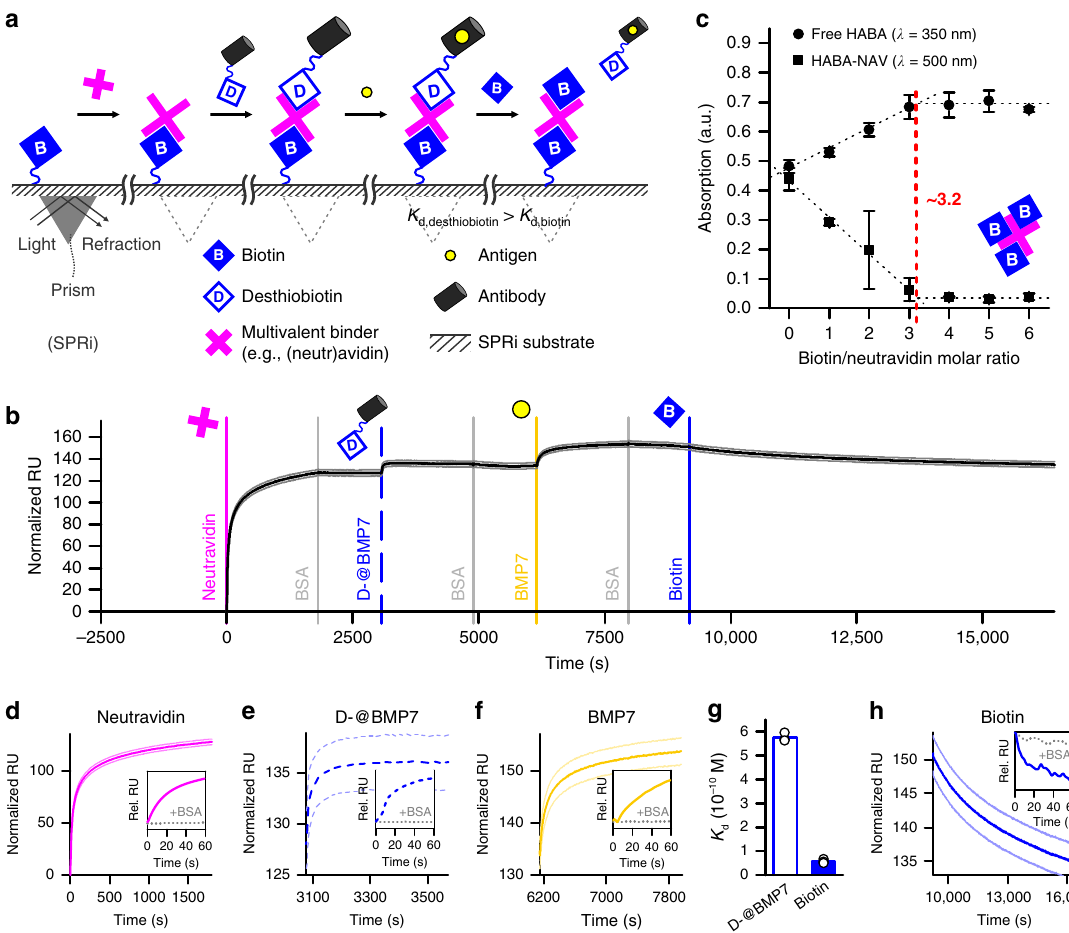
Fig. 1 Reversible functionalization via competitive supramolecular complexation. a , b Surface plasmon resonance imaging (SPRi) was used to monitor the (single) reversible functionalization of a biotinylated 2D substrate through supramolecular complexation of multivalent (i.e., with multiple binding pockets) (neutr)avidin and desthiobiotinylated antibody. c The multivalent nature of neutravidin was con fi rmed using spectrophotometric absorption analysis of 4 ′ -hydroxyazobenzene-2-carboxylic acid bound to neutravidin (HABA-NAV; λ = 500 nm), which was displaced by biotin resulting in unbound (i.e., free) HABA ( λ = 350 nm). b , d – f Following a cascade binding strategy, neutravidin, desthiobiotinylated antibody against bone morphogenetic protein 7 (D-@BMP7), and BMP7 were sequentially complexed onto the biotinylated SPRi substrate. g Based on a difference in binding af fi nity, h supramolecular displacement of D-@BMP7 by biotin was achieved, resulting in the release of the antibody/antigen complex. The insets show the averaged response curves of a speci fi c analyte injection versus a non-speci fi c analyte (i.e., BSA) injection. All magenta data indicate (neutr)avidin. All blue/white dashed data indicate D-@BMP7. All yellow data indicate BMP7. All blue solid data indicate biotin. All light-colored data indicate ± standard deviation ( n = 6). All error bars indicate ± standard deviation ( n